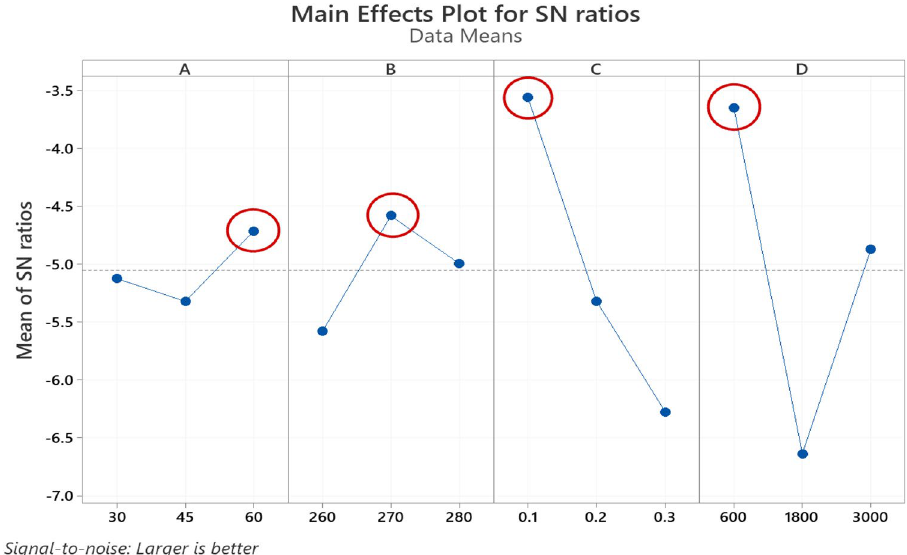
Figure 7. Main Effects Plot for S/N ratios GRG.